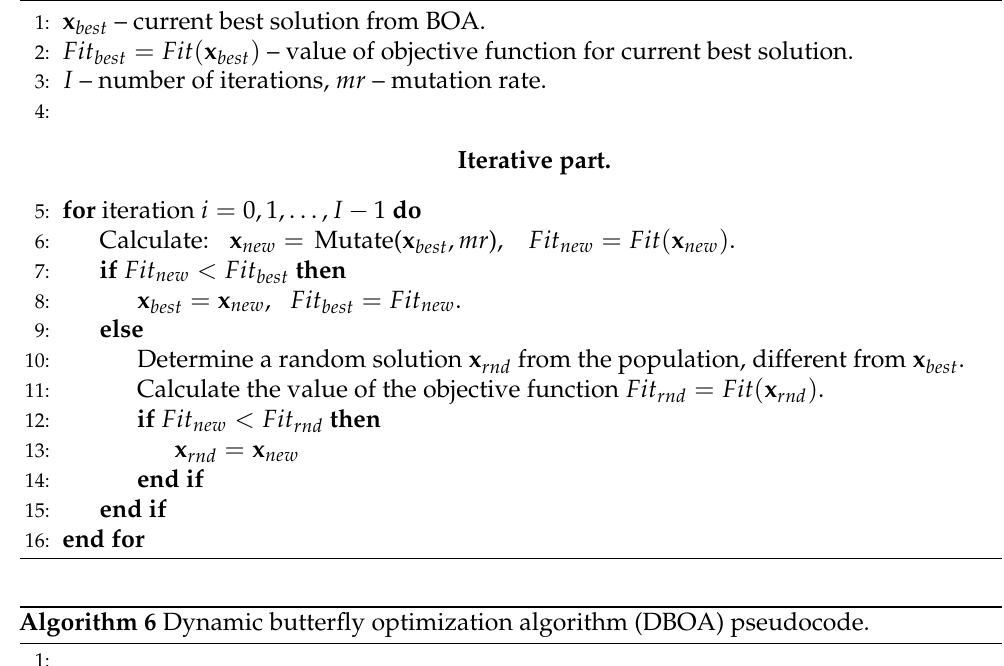
Algorithm 5 Novel local search algorithm based on mutation operator (LSAM) pseudocode.